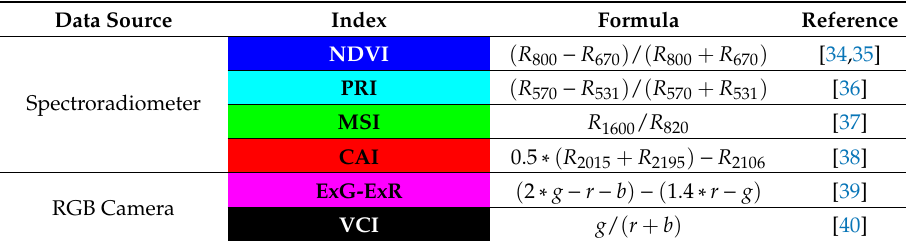
Table 1. Vegetation Indices (VIs) included in the